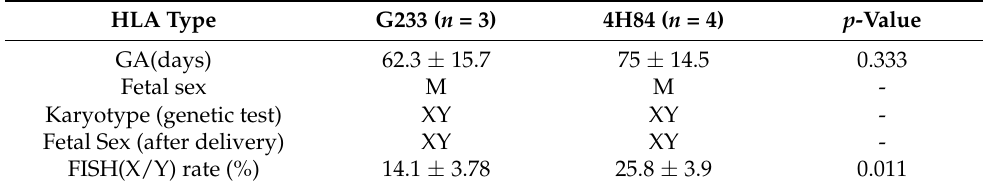
Figure 4. Distinguishing fetal cells from maternal cells using FISH probes for X (spectrum orange) and Y chromosome (spectrum green) in cells captured by antibodies. ( A ) FISH analysis results of cells captured using G233 and 4H84 antibodies. A larger number of fetal cells were identified in the cells captured using the 4H84 antibody. ( B ) Percentage of FISH signals-XY probe type of G233 and 4H84 clone by cell count. (*: p -value < 0.05). Table 3. Trophoblast contents using fluorescence in situ hybridization.